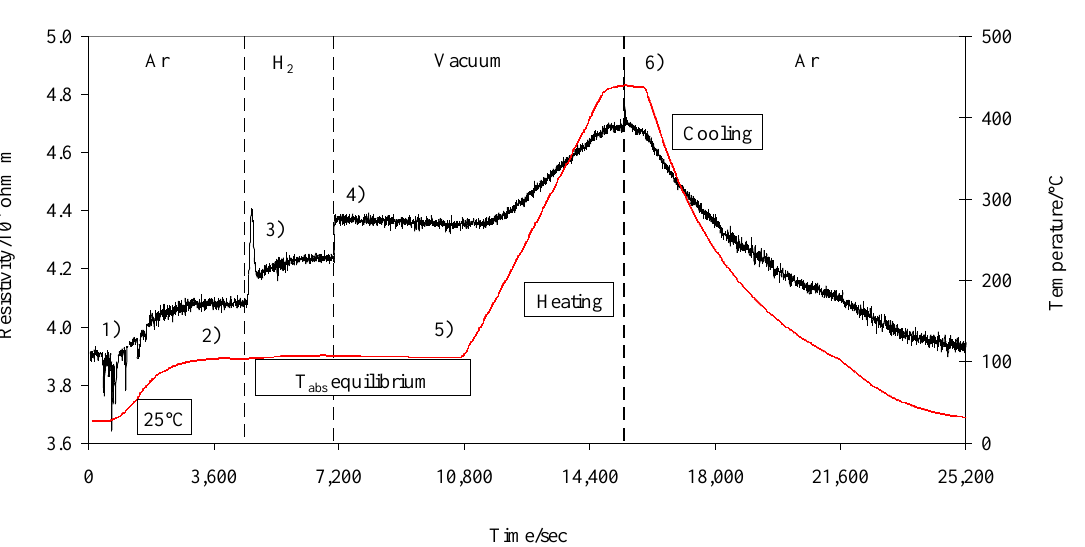
Figure 3. Total resistivity (  ), contribution due to the scattering measured in pure hydrogen (  i ), and contribution of  T measured in argon of Pd–Ag 21 wt. % thin foil. For all temperatures, the measurements were performed at 100 kPa of hydrogen.